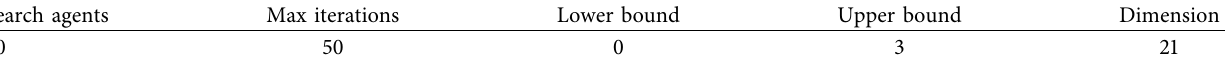
Table 2: SHO parameter settings.